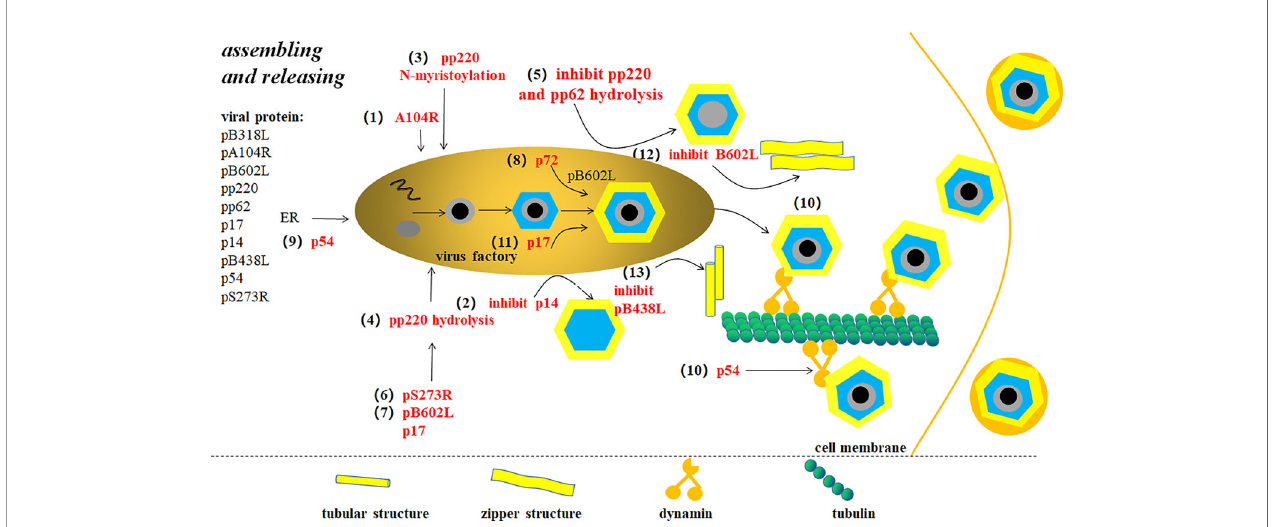
FIGURE 6 | ASFV assembly and release (9). Changes in the virus particle morphology occur in virus factory (VF). (1) A104R is located in the core shell and involved in ASFV genome packaging. (2) p14 expression inhibition produces defective interference particles without a central nucleoid. (3) The core shell adsorbs on the inner membrane depending on pp220 N-bean acrylamide. (4) pp220 hydrolysis separates the core shell from the inner capsule membrane, thus concentrating, condensing, and merging the nucleus. (5) pp220 and pp62 hydrolysis inhibition leads to non-nuclear or non-infectious virus particle production. (6) ASFV proteolytic enzyme pS273R catalyzes protease processing of polyprotein precursors. (7) Proteins that affect pp220 and pp62 hydrolysis include pB602L and p17. (8) The assembly of the major capsid protein p72 requires the assistance of B602L-encoded molecular chaperone. (9) p54 expression inhibition interrupts endoplasmic reticulum (ER) transfer to virus assembly site. (10) P54 proteins interact with microtube power complexes by connecting directly to dynein. Newly-synthesized viruses are linked to kinesins, which drives the virus to move from VF to extracellular. (11) p17 plays an important role in capsule precursor conversion into an icosahedron intermediate. (12) pB602L synthesis inhibition forms abnormal “ zip-like ” structure instead of icosahedron. (13) Membrane protein pB438L expression inhibition forms abnormal tubular structure instead of